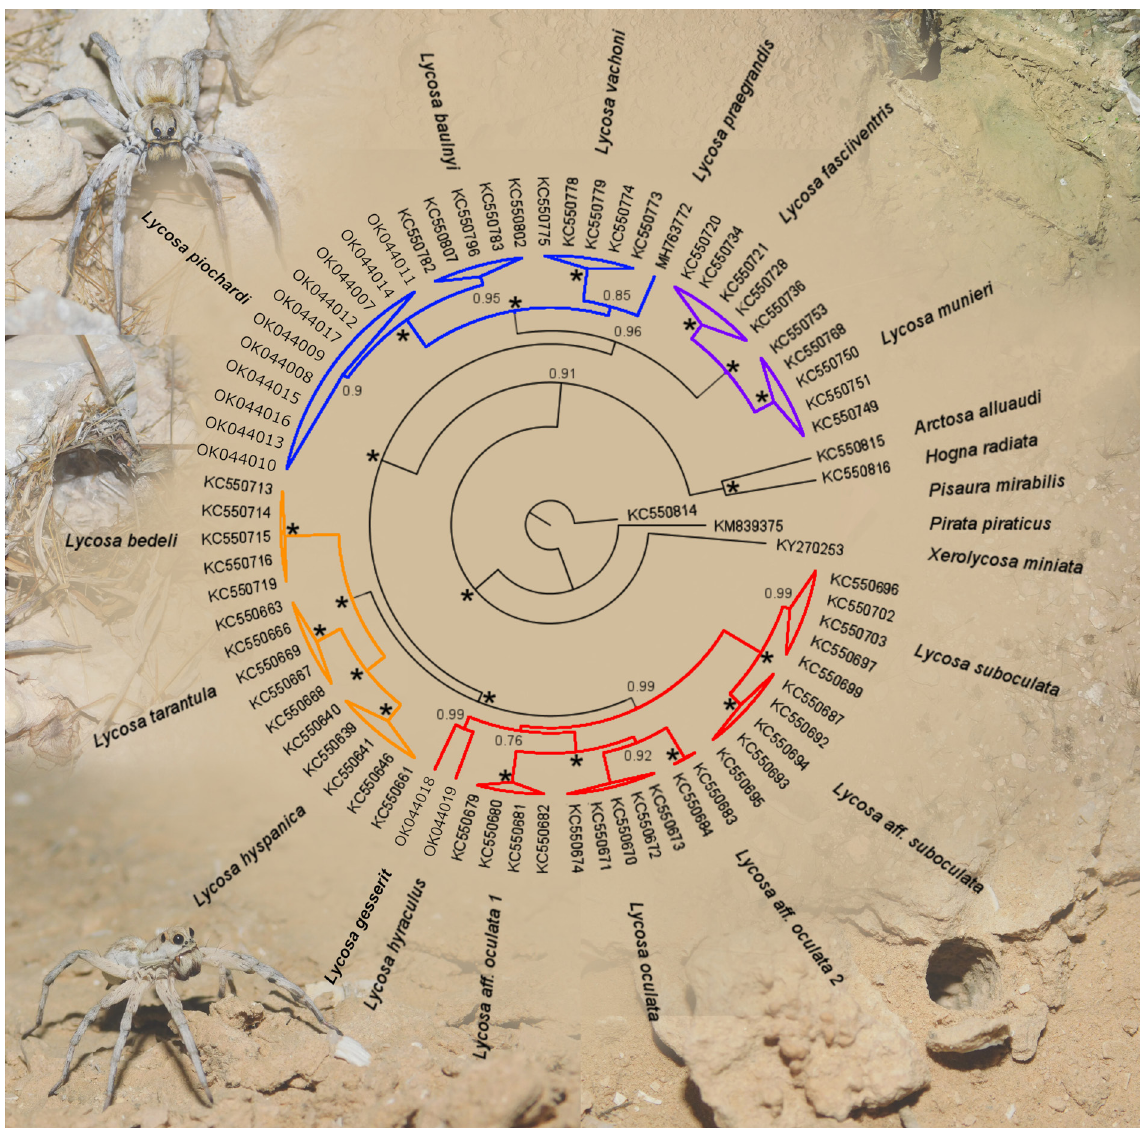
Fig. 23. Bayesian phylogeny cladogram, showing the topology of Lycosa Latreille, 1804. Posterior probabilities of 1 marked by asterisk. Specimens used for this phylogeny detailed in Table 2. Photos by I. Armiach